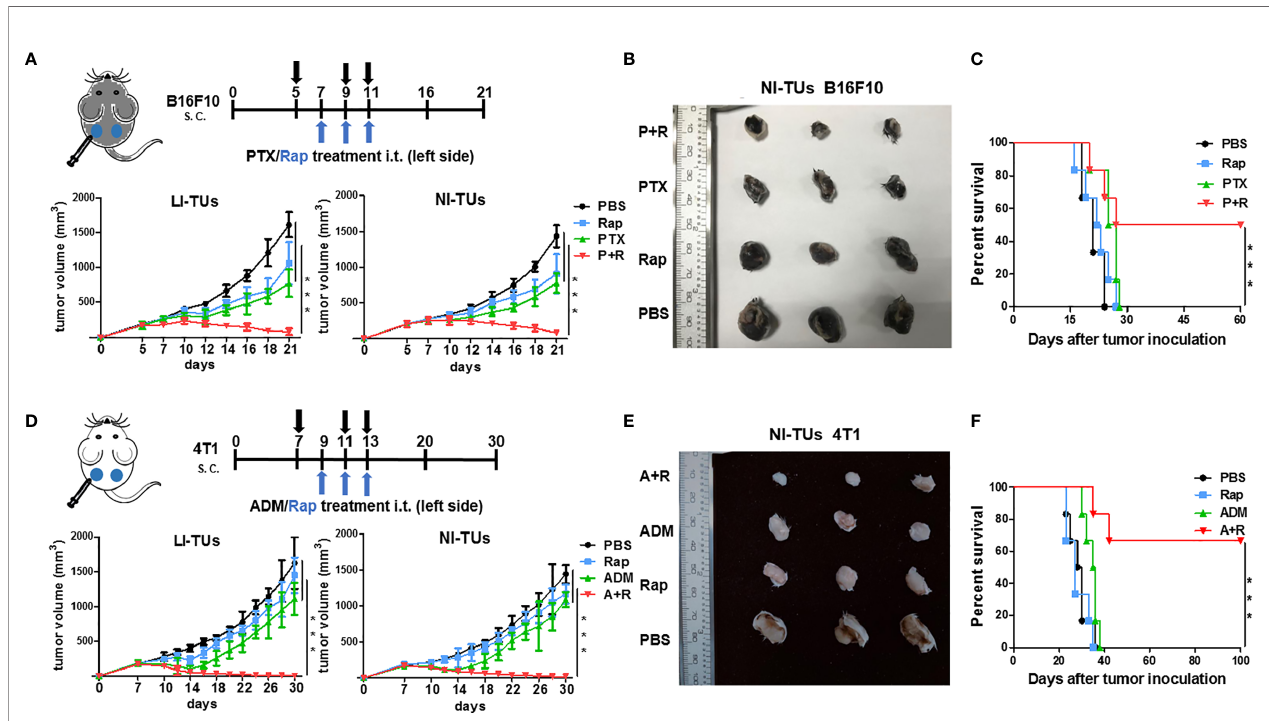
FIGURE 3 | The inhibition of in vivo tumor growth using a local CAER treatment. (A) The treatment scheme (upper panel) and in vivo growth curve (lower panel) of B16F10 cell-derived tumors. (B) Representative images of B16F10 cell-derived noninjected tumors on day 16. (C) The survival curves for C57BL/6 mice bearing B16F10 cell-derived tumors. (D) The treatment scheme (upper panel) and in vivo growth curve (lower panel) of 4T1 cell-derived tumors. (E) Representative images of 4T1 cell-derived noninjected tumors on day 20. (F) The survival curves for BALB/c mice bearing 4T1 cell-derived tumors. LI-TUs, locally injected tumors; NI-TUs, noninjected tumors; n = 5 – 6 mice/group. *** P < 0.001 by Student ’ s t